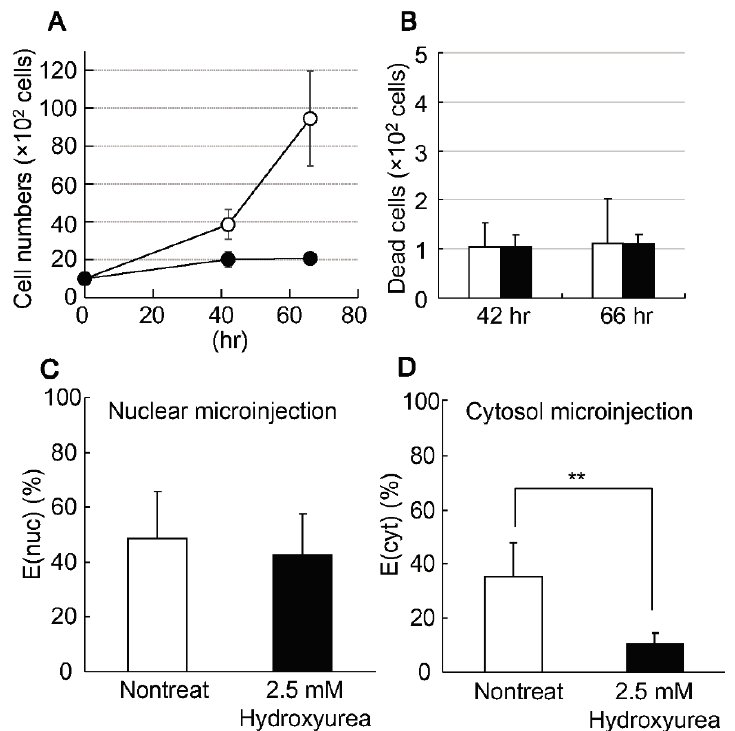
Figure 1. Synchronization of HeLa cells by hydroxyurea. Cell growth ( A ) and cell death ( B ) was monitored by counting the number of HeLa cells. The cells were cultured in the presence (closed) or absence (open) of 2.5 mM of hydroxyurea. The number of dead cells was counted by staining the cells with trypan blue. Gene expression of the EGFP after the microinjection of MC07.CMV-EGFP in the nucleus ( C ) or cytoplasm ( D ) of the non-treated cells (open) or synchronized cells (closed). Data are represented as the mean ± S.D. of triplicate experiments. The statistical differences were determined by the one-way ANOVA followed by Student’s t -test ( ** , p < 0.01). E(nuc), transgene expression after nuclear microinjection; E(cyt), transgene expression after cytoplasmic